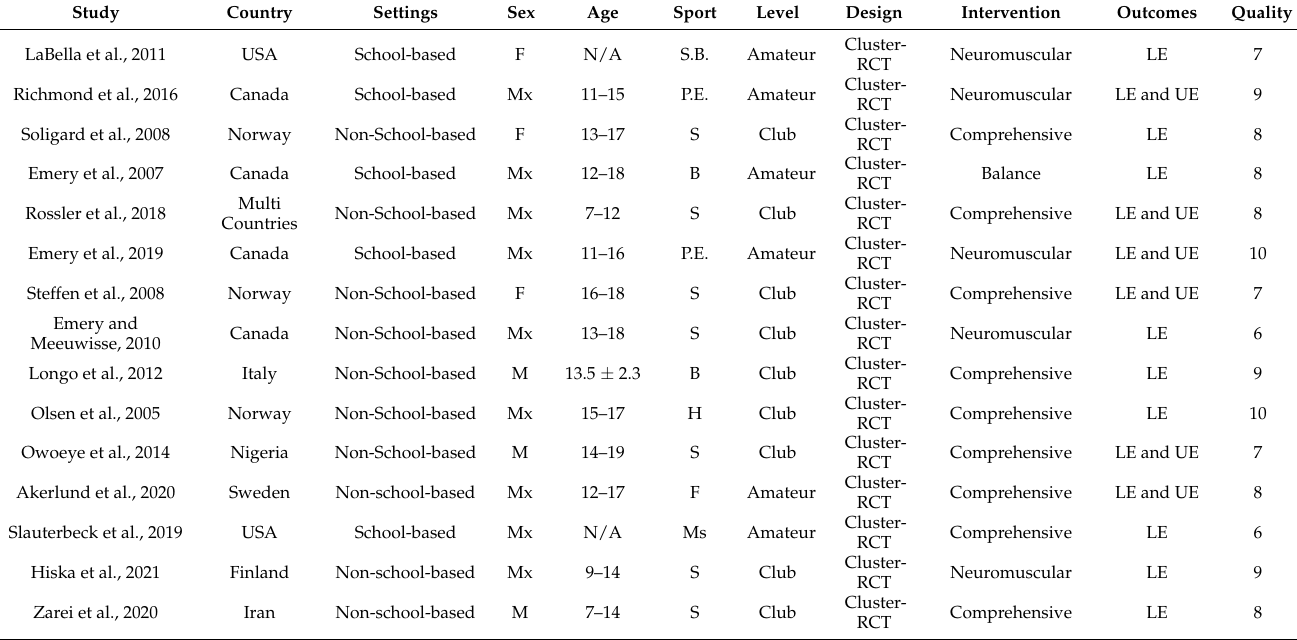
Table 2. Overall Situation of Identified Studies a